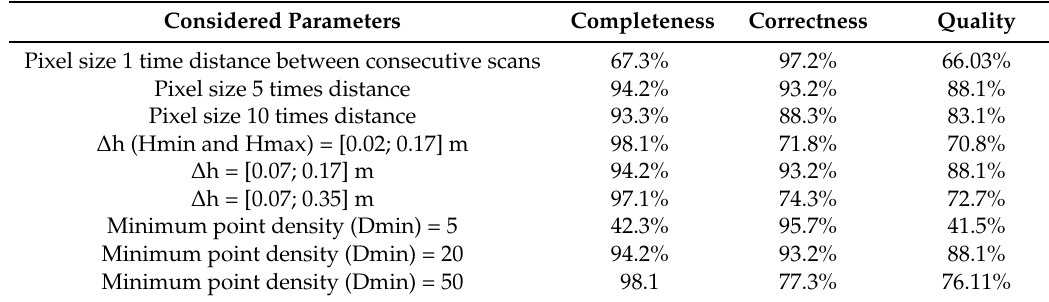
Table 6. Accuracy of the method for parameter values outside of the optimum